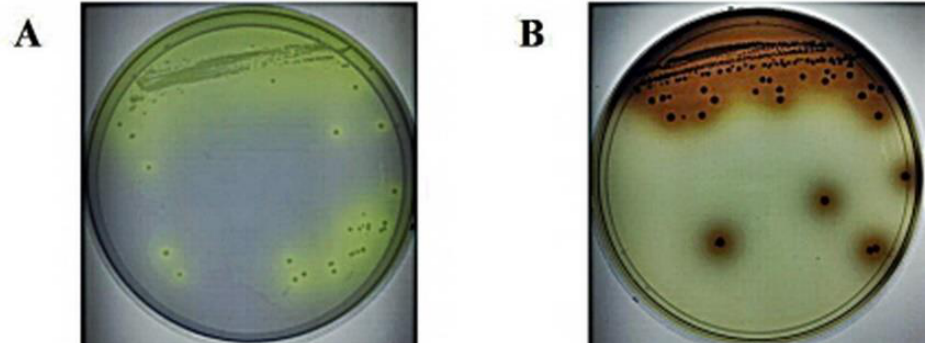
Figure 1. Screening of lactic acid bacteria with β -glucosidase activity from fermented plants: ( A ) single colony of strain URN103L in BCP agar, ( B ) positive reaction of strain. URN103L in esculin agar.